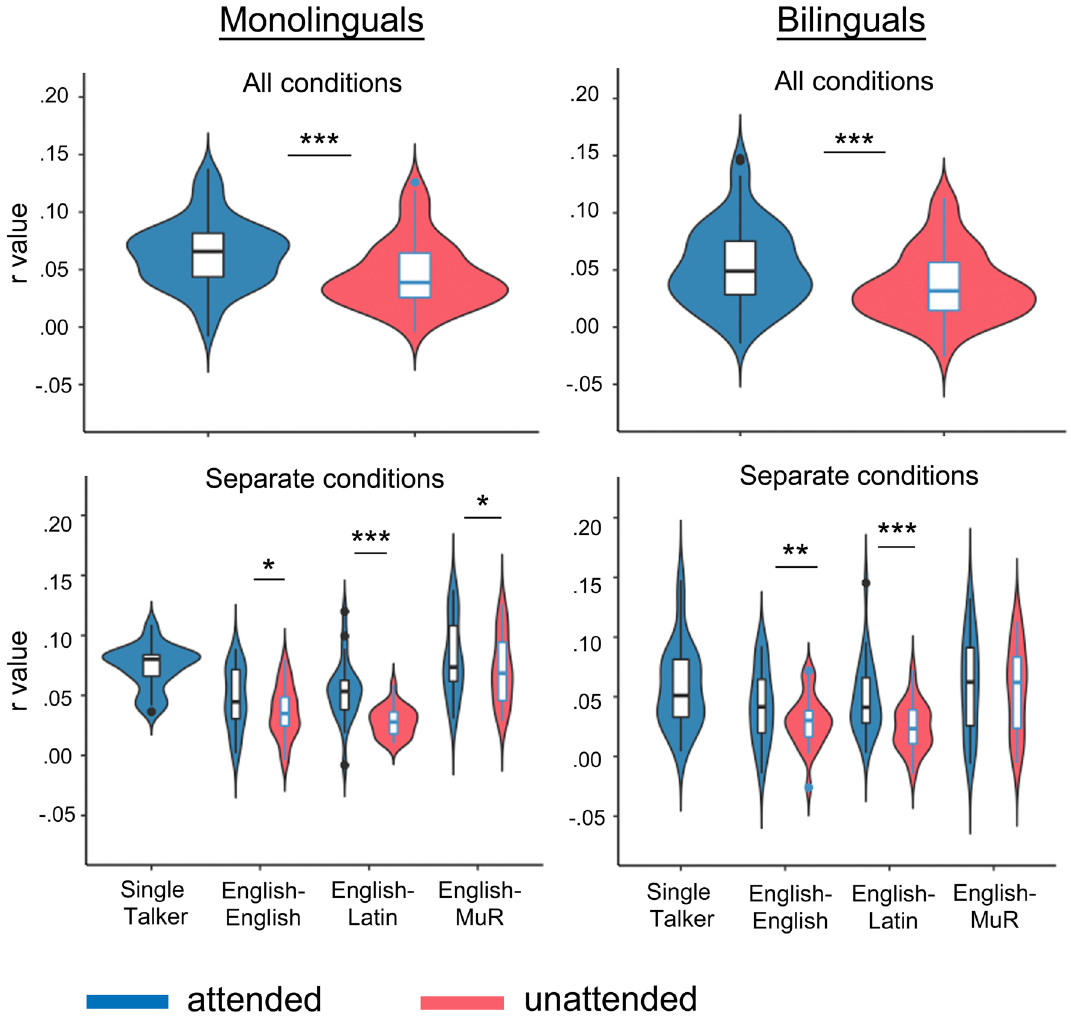
Figure 2. Reconstruction scores for attended and unattended streams per group and condition. Results show robust effects of attention on the reconstruction accuracy of speech envelopes, with higher reconstruction accuracy for the attended than for the unattended envelopes in both